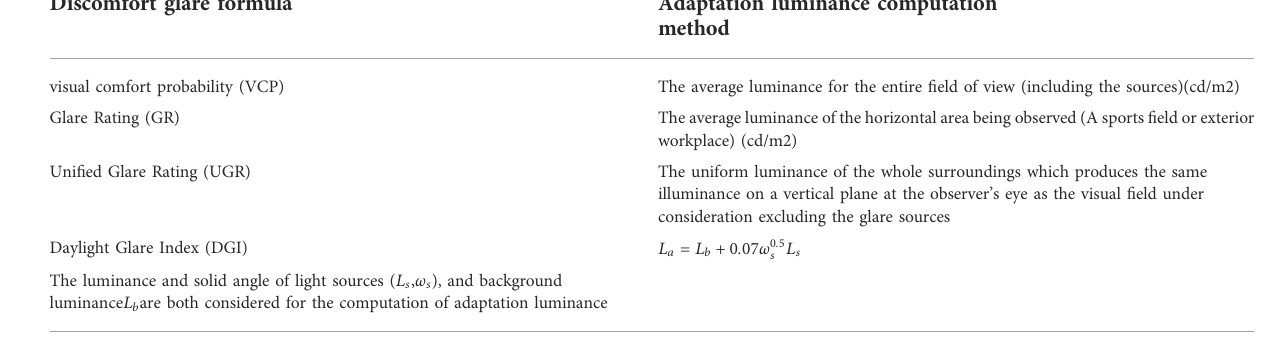
TABLE 1 Comparison on adaptation luminance computation methods of different discomfort glare formulae. Discomfort glare formula